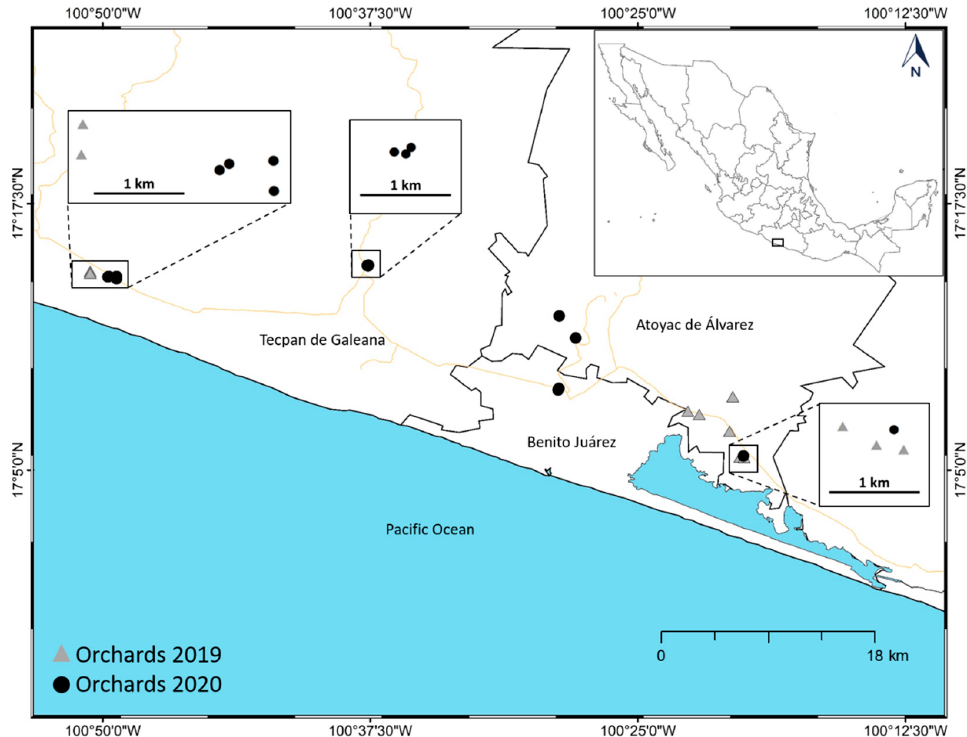
Figure 1. Location of orchards in Costa Grande Guerrero, Mexico. Orchards sampled in 2019 (gray triangles) and 2020 (black circles) are shown.